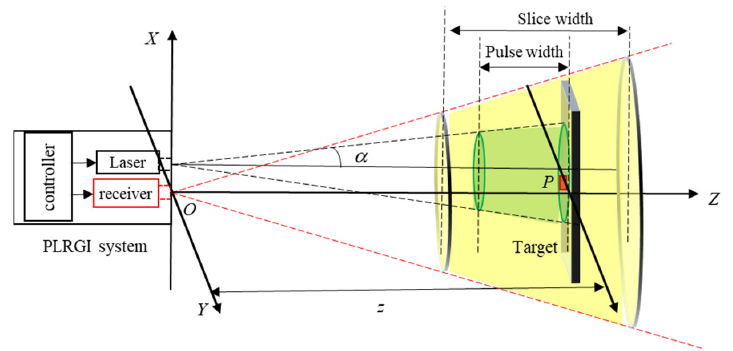
Figure 3. Description and Time sequence of the MSI method with three slices. ( a ) The three targets are in three adjacent slices respectively; ( b ) Time sequence of the MSI method. The same delay time belongs to the same slice, and the slice width is small and only one target echo can be passed. Take the slice which contains target ① as an example to calculate the RIP of a single pulse. The coordinate system established is shown in Figure 4. Here α is the half diver- gence angle of the laser beam. The laser is assumed to emit a pulse of energy E 0 within a short period τ P . Speed of the laser in water is c w . Target is placed at position z away from are not considered.